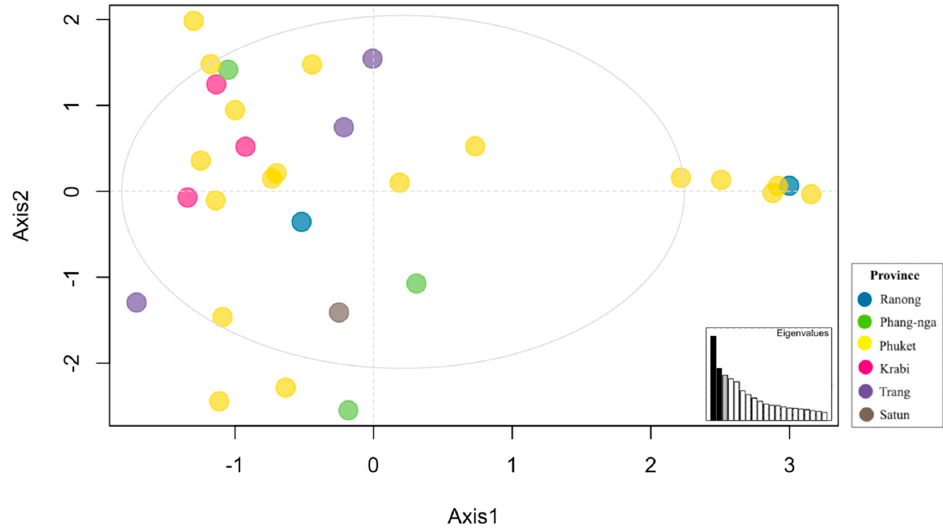
Figure 3. Principal component analysis (PCA) showing the partition of individual T. aduncus from the Thai Andaman Sea.